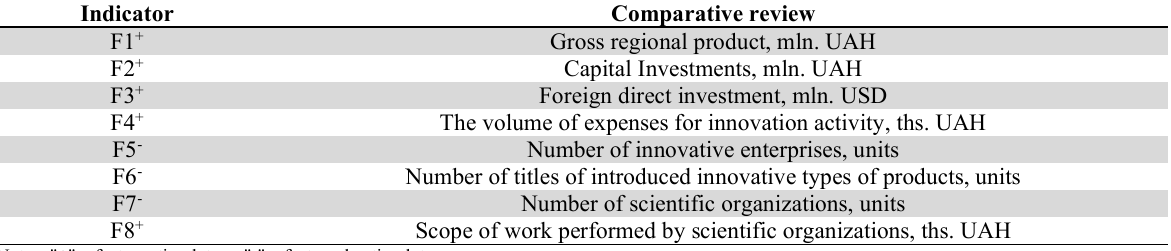
The indicators system that reflects the level of the region socio-economic development